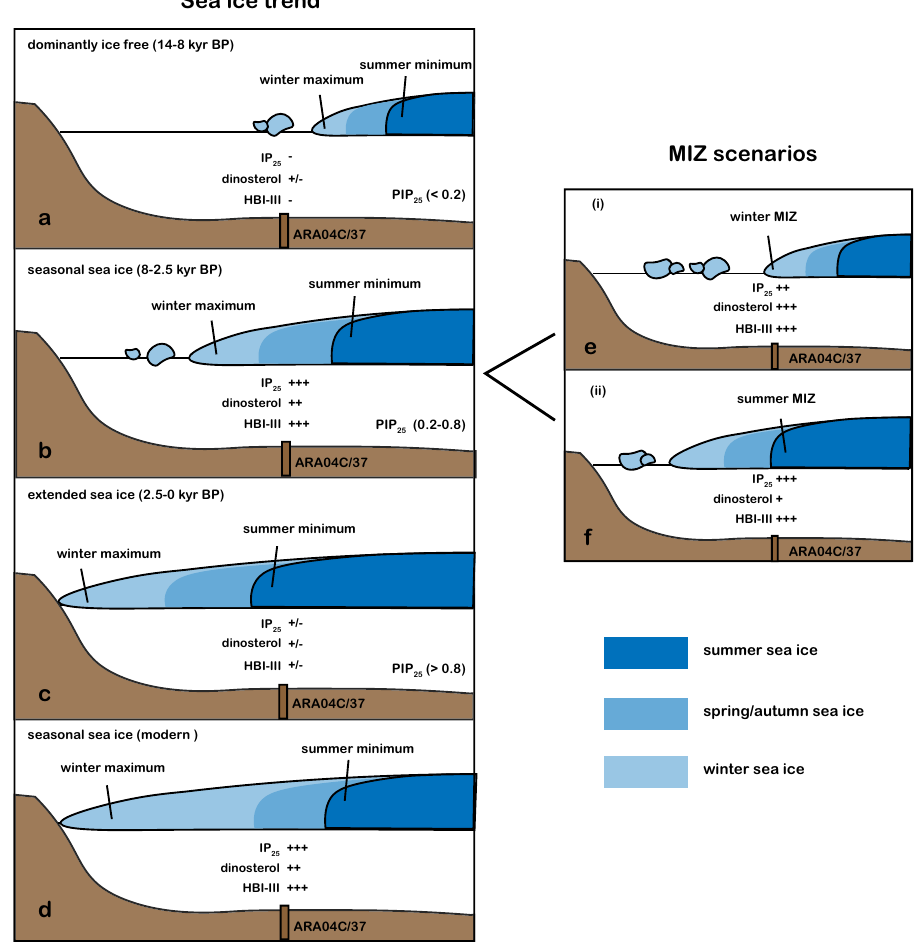
Fig. 8 Schematic illustration of sea-ice variability in the southern Beaufort Sea. a – c Paleo sea-ice variability based on PIP 25 record, d modern sea-ice conditions according to sea-ice concentrations from 1988 to 2007 (see Fig. 2). e – f Show the winter and summer MIZ conditions of seasonal sea